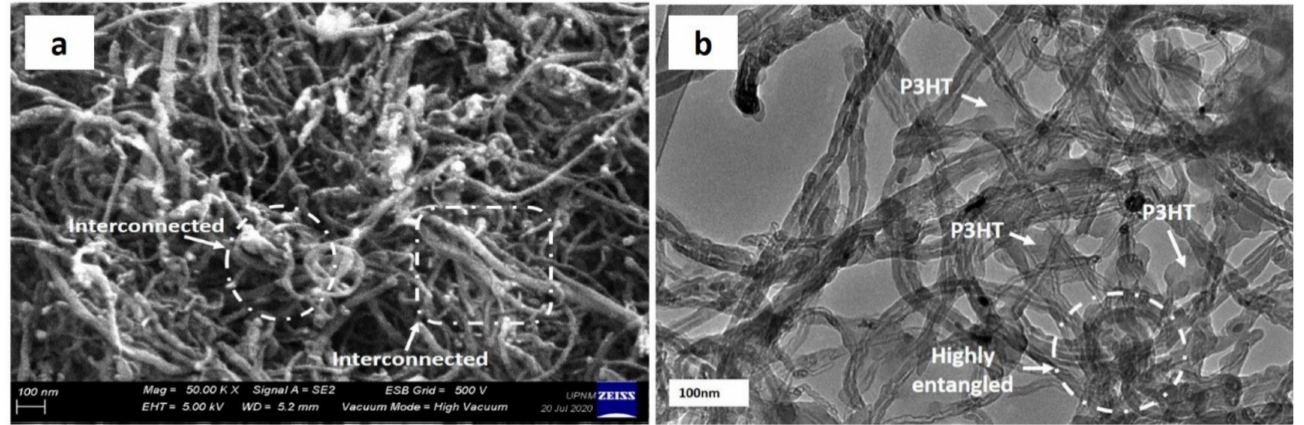
Figure 3. Entangled nature of MWCNT ( a ) under FESEM and ( b ) under HRTEM. Reproduced from